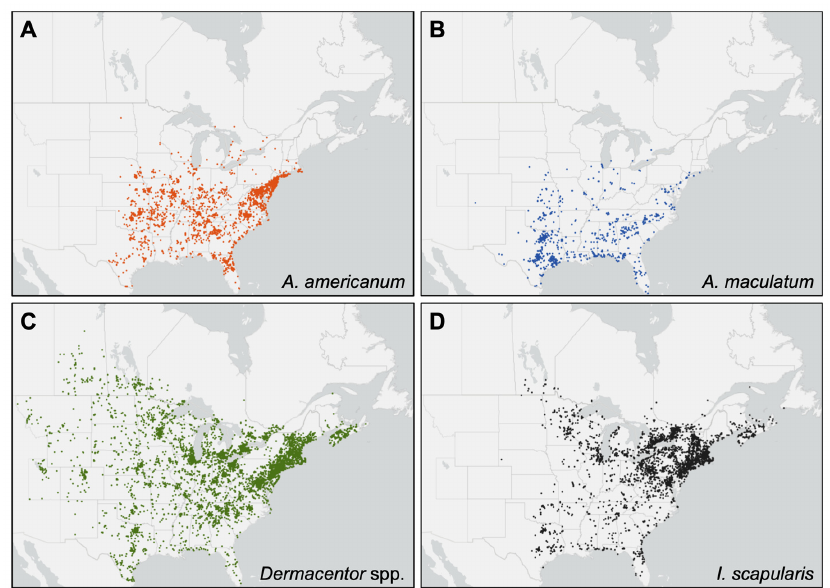
Figure 2. Distribution of iNaturalist observations of target tick species: ( A ) Amblyomma americanum ; ( B ) Amblyomma maculatum ; ( C ) Dermacentor spp.; ( D ) Ixodes scapularis. Data used to create these distribution maps can be found in Table S2. Insects 2022 , 13 , x FOR PEER REVIEW